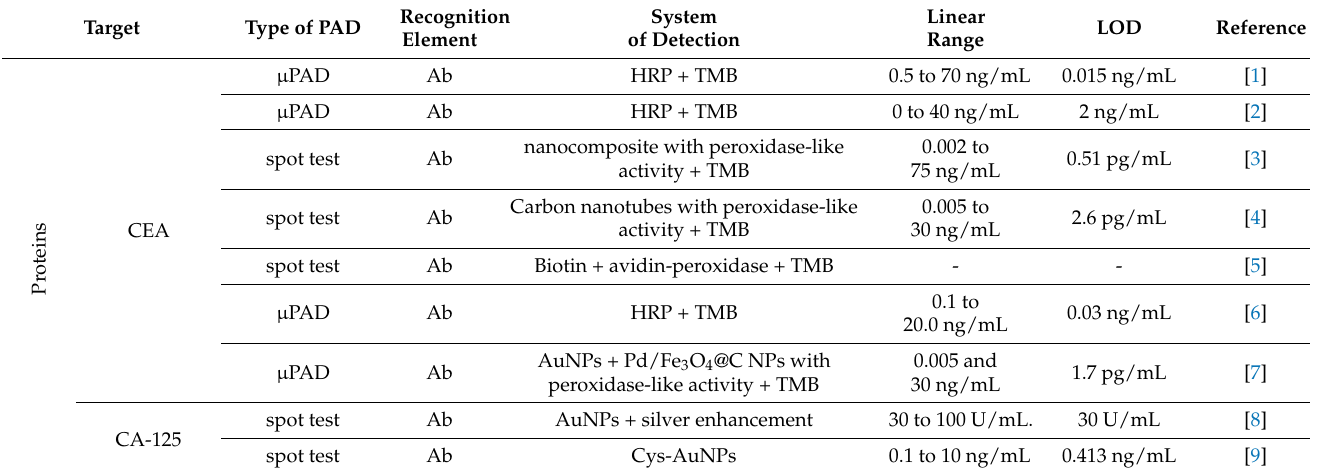
Table 1. Colorimetric paper-based sensors for cancer biomarkers reported in the last 12 years.